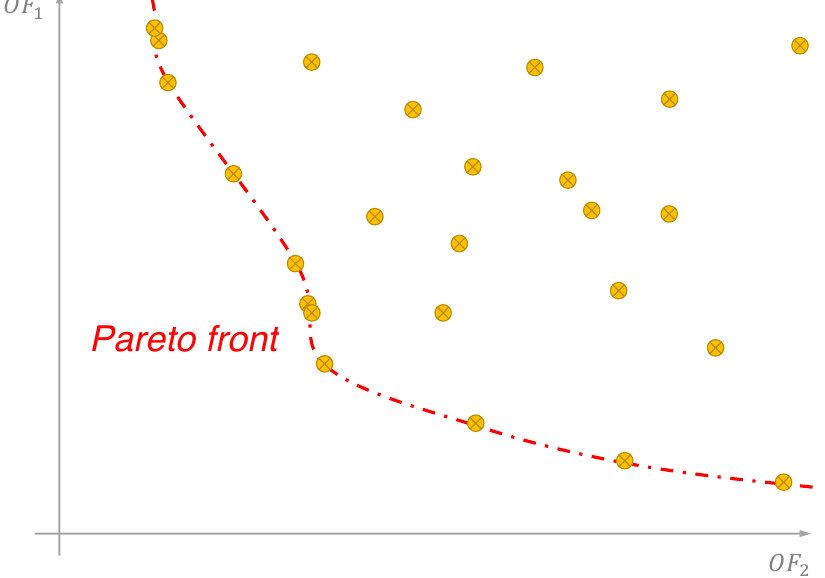
Figure 12. A representative example of a Pareto front for a two-dimensional optimization